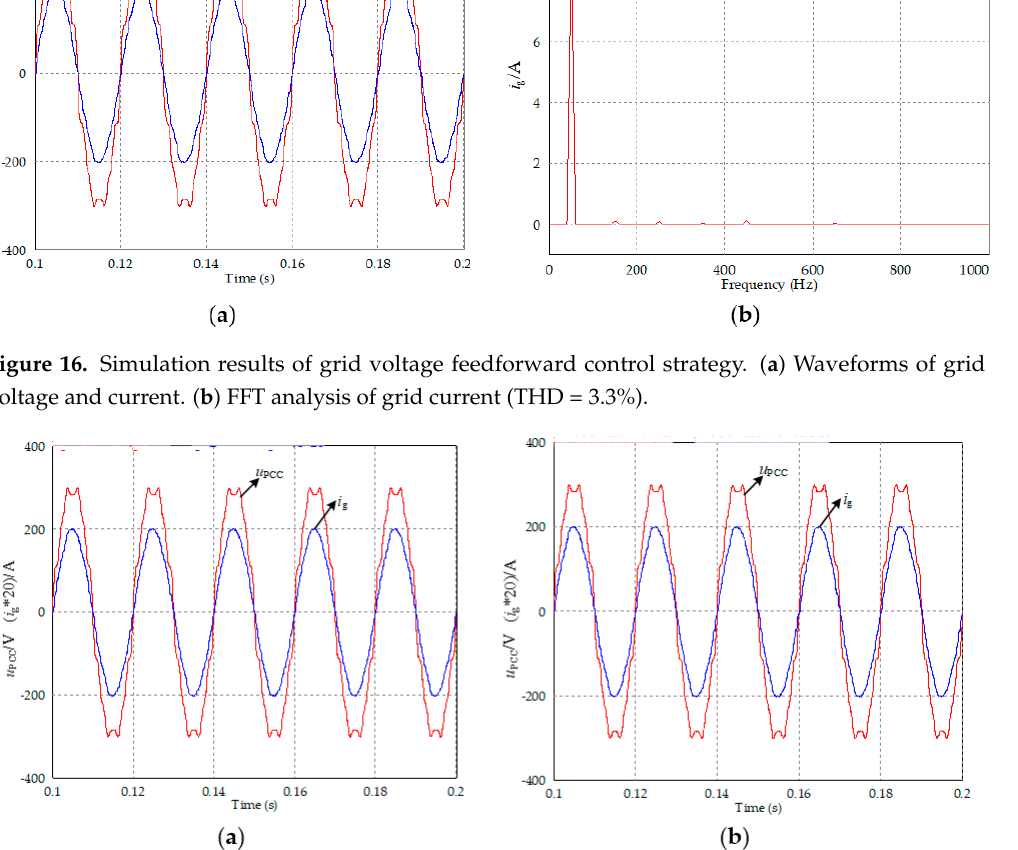
Figure 17. Simulation results of the proposed control strategy. ( a ) Waveforms of grid voltage and current. ( b ) FFT analysis of grid current (THD = 2.8%).